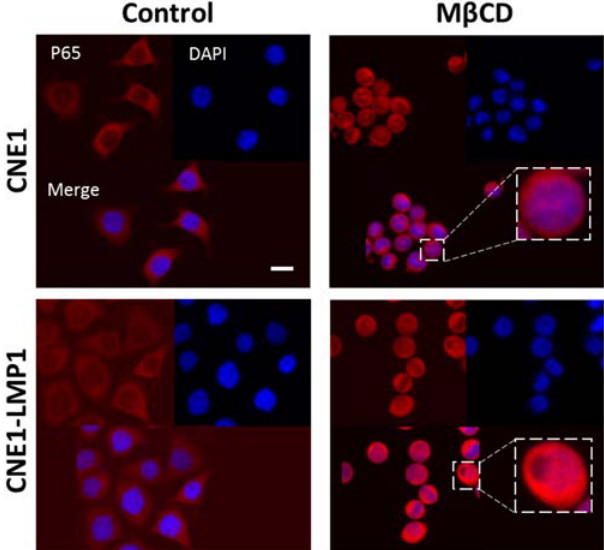
Fig. 3. NF-kB p65 nuclear translocation in CNE1 and CNE1- LMP1 cells treated with 40 mM M (cid:1) CD for 15 min. These images were representative of three independent experiments. Scale bar, 20 (cid:2) m.